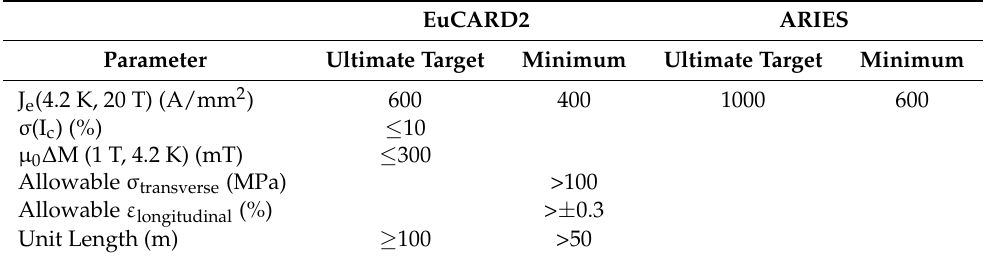
Table 1. Targets and minimum required performance for the REBCO tapes in EuCARD2 and